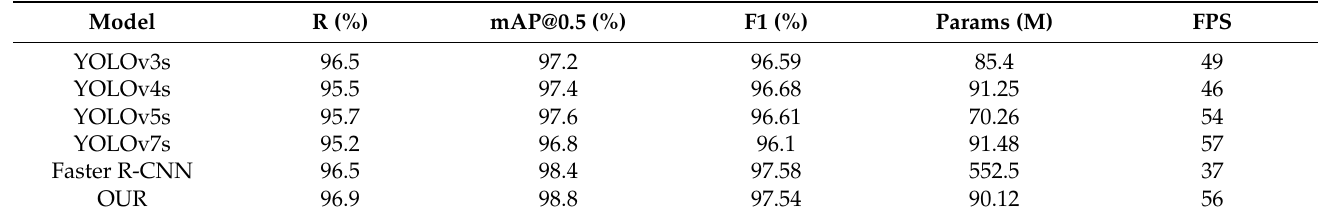
Table 8. Comparison of different detector models on the PCB